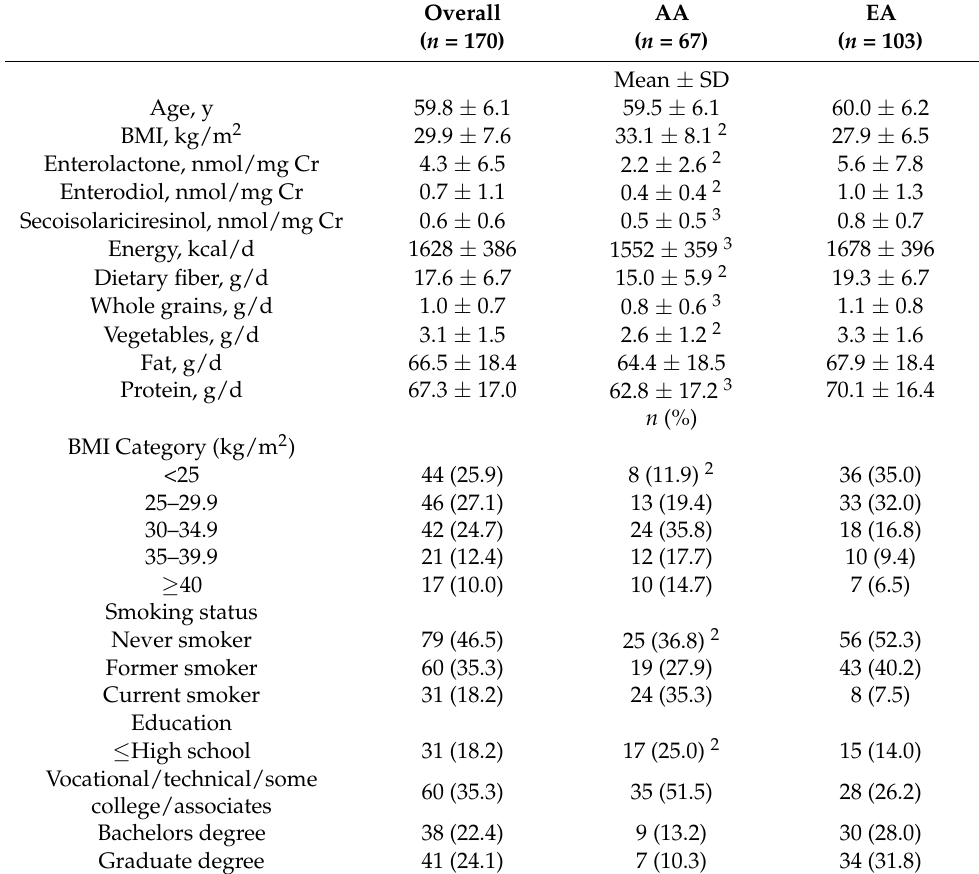
Table 1. Baseline descriptive characteristics of women participating in a flaxseed intervention study 1 . Overall ( n = 170)